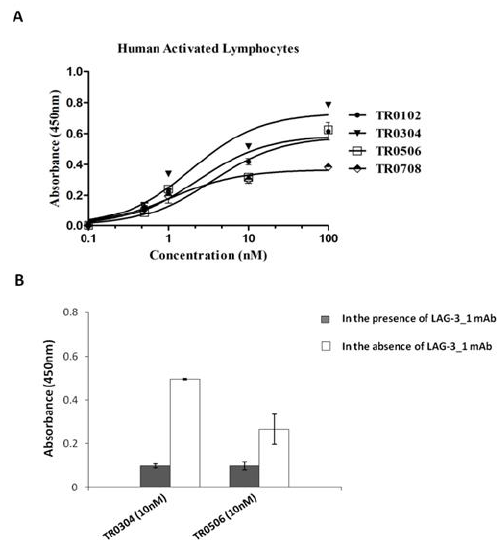
Figure 4. Binding affinity of the selected tribodies for activated lymphocytes in the absence or presence of LAG-3_1 mAb. ( A ) Cell ELISA assays were performed by using increasing concentrations (0.1 – 100 nM) of tribodies on activated hPBMCs. ( B ) Cell ELISA assays were performed by measuring the binding of the indicated tribodies to human-activated lymphocytes in the absence (empty bars) or presence (dark bars) of the parental anti-LAG-3 antibody used at saturating concentration. The binding values are reported as the mean of at least three determinations obtained in three independent experiments. Error bars depict means ± SD. Table 2. Kd values obtained from the binding curves of the tribodies to activated hPBMCs. Kd TR0102 TR0304 TR0506 TR0708 hPBMCs 2.265 nM 1.910 nM 3.439 nM 1.057 nM 2.5. Evaluation of Tribody Interference in the Binding of ICs with Their Ligands The unexpected low binding to LAG-3 protein can be explained by problems related to its low stability during the storage, assessed by monitoring (spectrofotometrically) its concentration and analyzing its degradation by SDS-PAGE over time. Thus, we decided to test the TR0304 and TR0506 TRBs on cells expressing LAG-3 in their native confor- mation. To confirm the binding specificity of the tribodies for LAG-3, we tested them on lymphocytes expressing high levels of LAG-3 in competitive ELISA assays with the pa- rental anti-LAG-3 antibody. As shown in Figure 4B, the binding of tribodies TR0304 and TR0506 on human activated lymphocytes was significantly reduced in the presence of sat- urating concentrations (300 nM) of anti-LAG-3 mAb, indicating the specificity of these tribodies for LAG-3. To further confirm the binding specificity of the tribodies for LAG-3, we investigated their binding and biological effects on the HuT78 cell line, which is derived from CD4+ human T cell lymphoma and expresses high levels of LAG-3 receptor, but low or absent levels of PD-1 and PD-L1. In order to evaluate the ability of the tribodies to bind to these cells, we tested them at increasing concentrations, in parallel with the LAG-3_1 parental mAb, by cell ELISA. We found that the TR0304 and TR0506 tribodies bound to the cells with a comparable or even better specificity (Figure 5A). Thus, we also tested the ability of these tribodies to activate HuT78 cells. To this aim, we treated the cells with TR0304